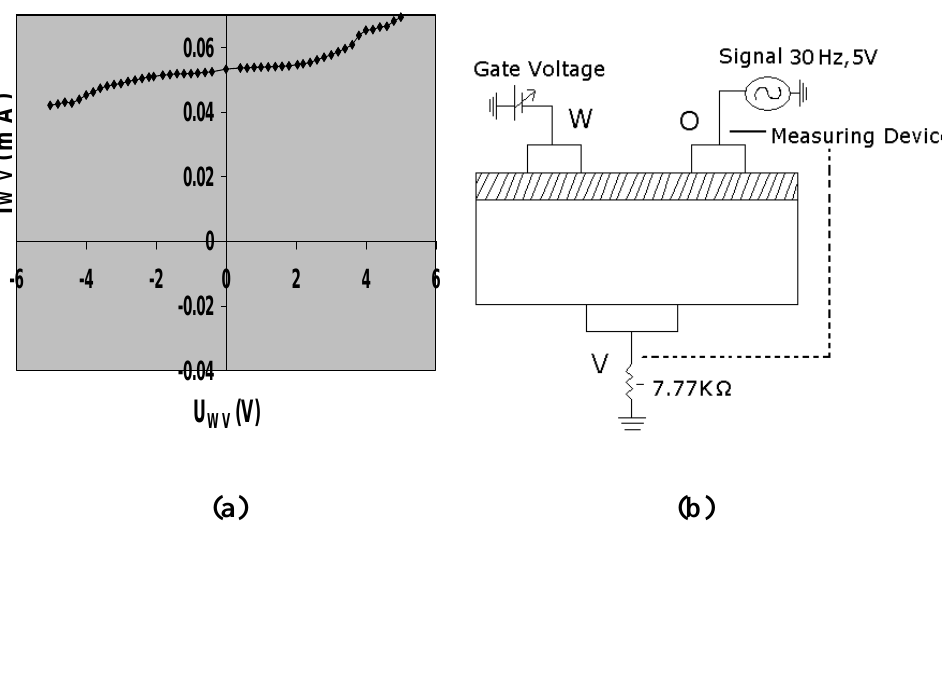
Figure 2. (a) Current/voltage characteristics of a CdS based TEMPOS structure in configuration 1; (b) the principle measuring setup for the current/voltage determination in configuration